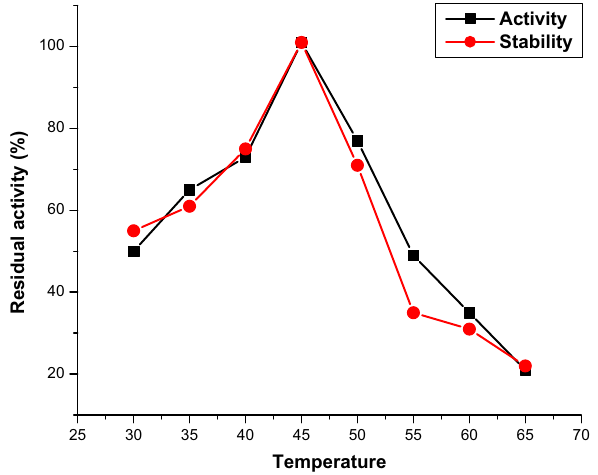
Figure 2. Effect of temperature on activity and stability of purified chitinase from S. maltophilia .